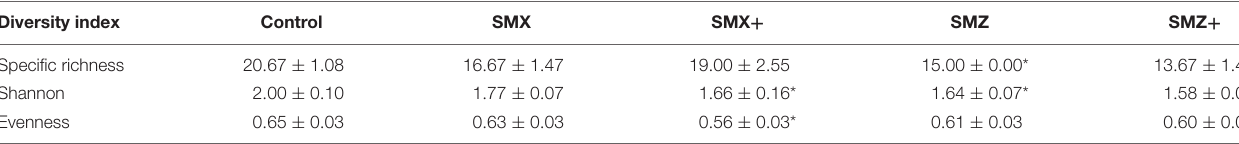
TABLE 3 | Structure and diversity of diatom community non-exposed (control) and exposed to 500 or 5,000 ng L − 1 of sulfamethoxazole (SMX) or sulfamethazine (SMZ) after 28 days or exposure, represented by diversity index (specific richness, Shannon, evenness). Diversity index Control SMX SMX